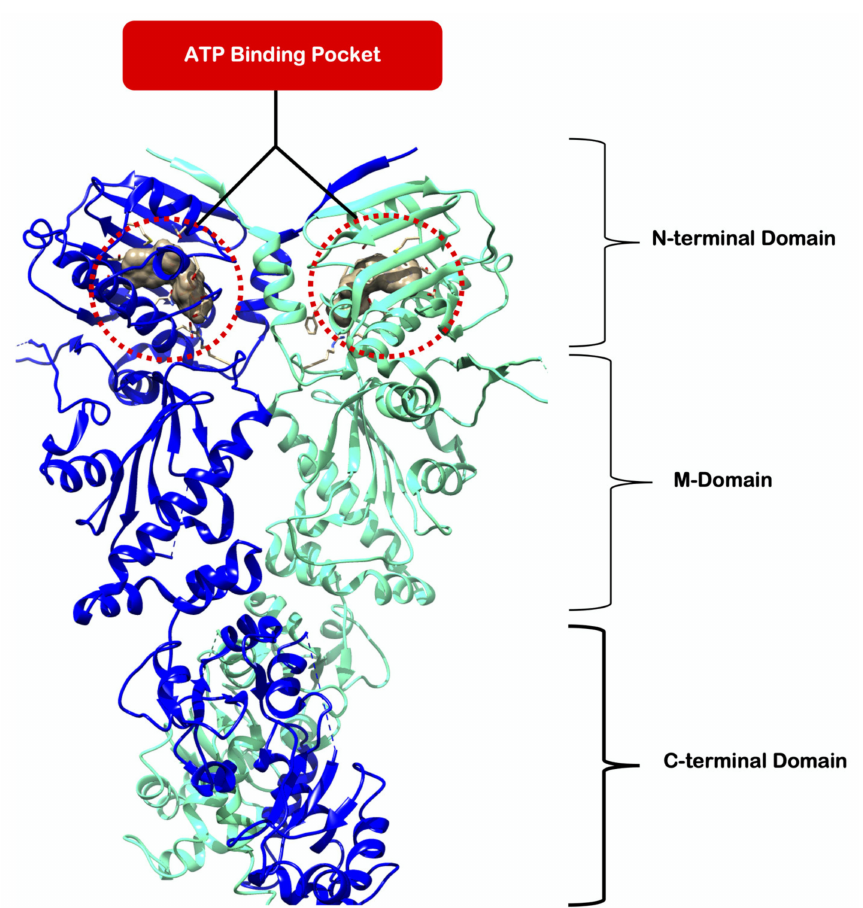
Figure 1. Crystal structure of Hsp90 dimer (PDB ID: 2CG9) [13]. The red dashed cycle highlights an ATP-binding